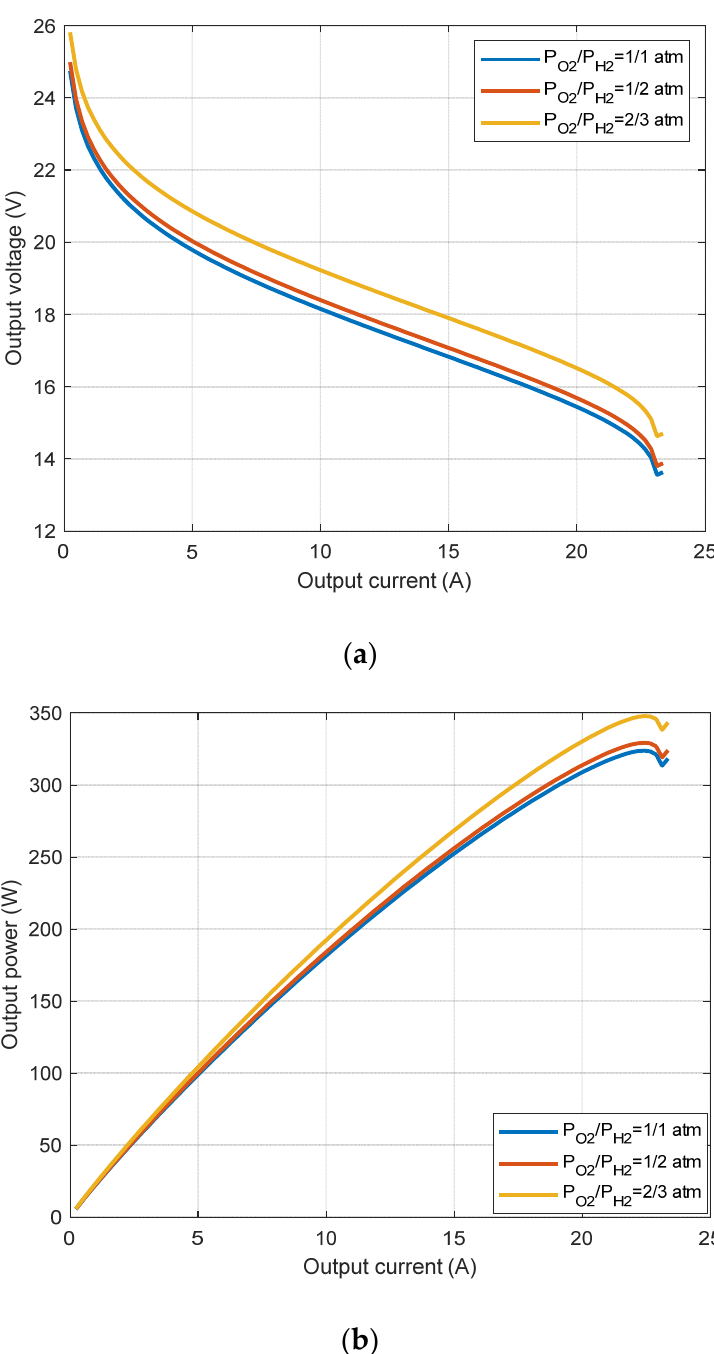
Figure 16. Characteristics of 250 W stack under various pressures: ( a ) current-voltage and ( b ) cur- rent-power.